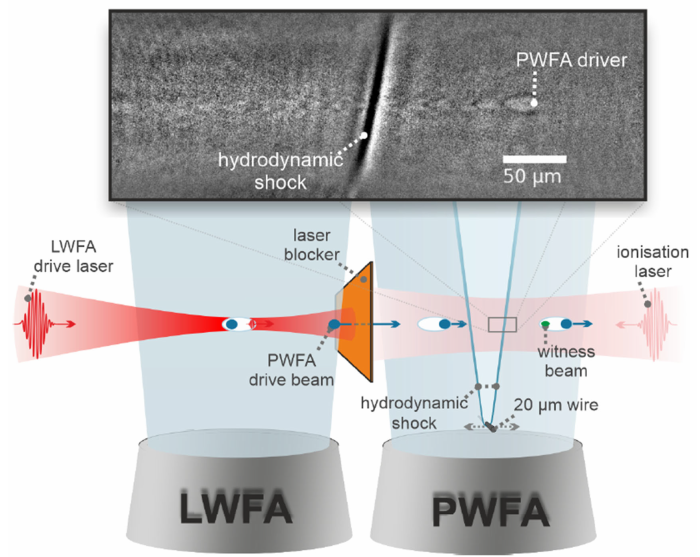
Figure 10. Gas-dynamic density downramp injection, realized by wire-induced shocks in the PWFA gas jet. Shadowgraphy reveals both the PWFA-driven plasma wave and the hydrodynamic shock profile (figure from [50]).